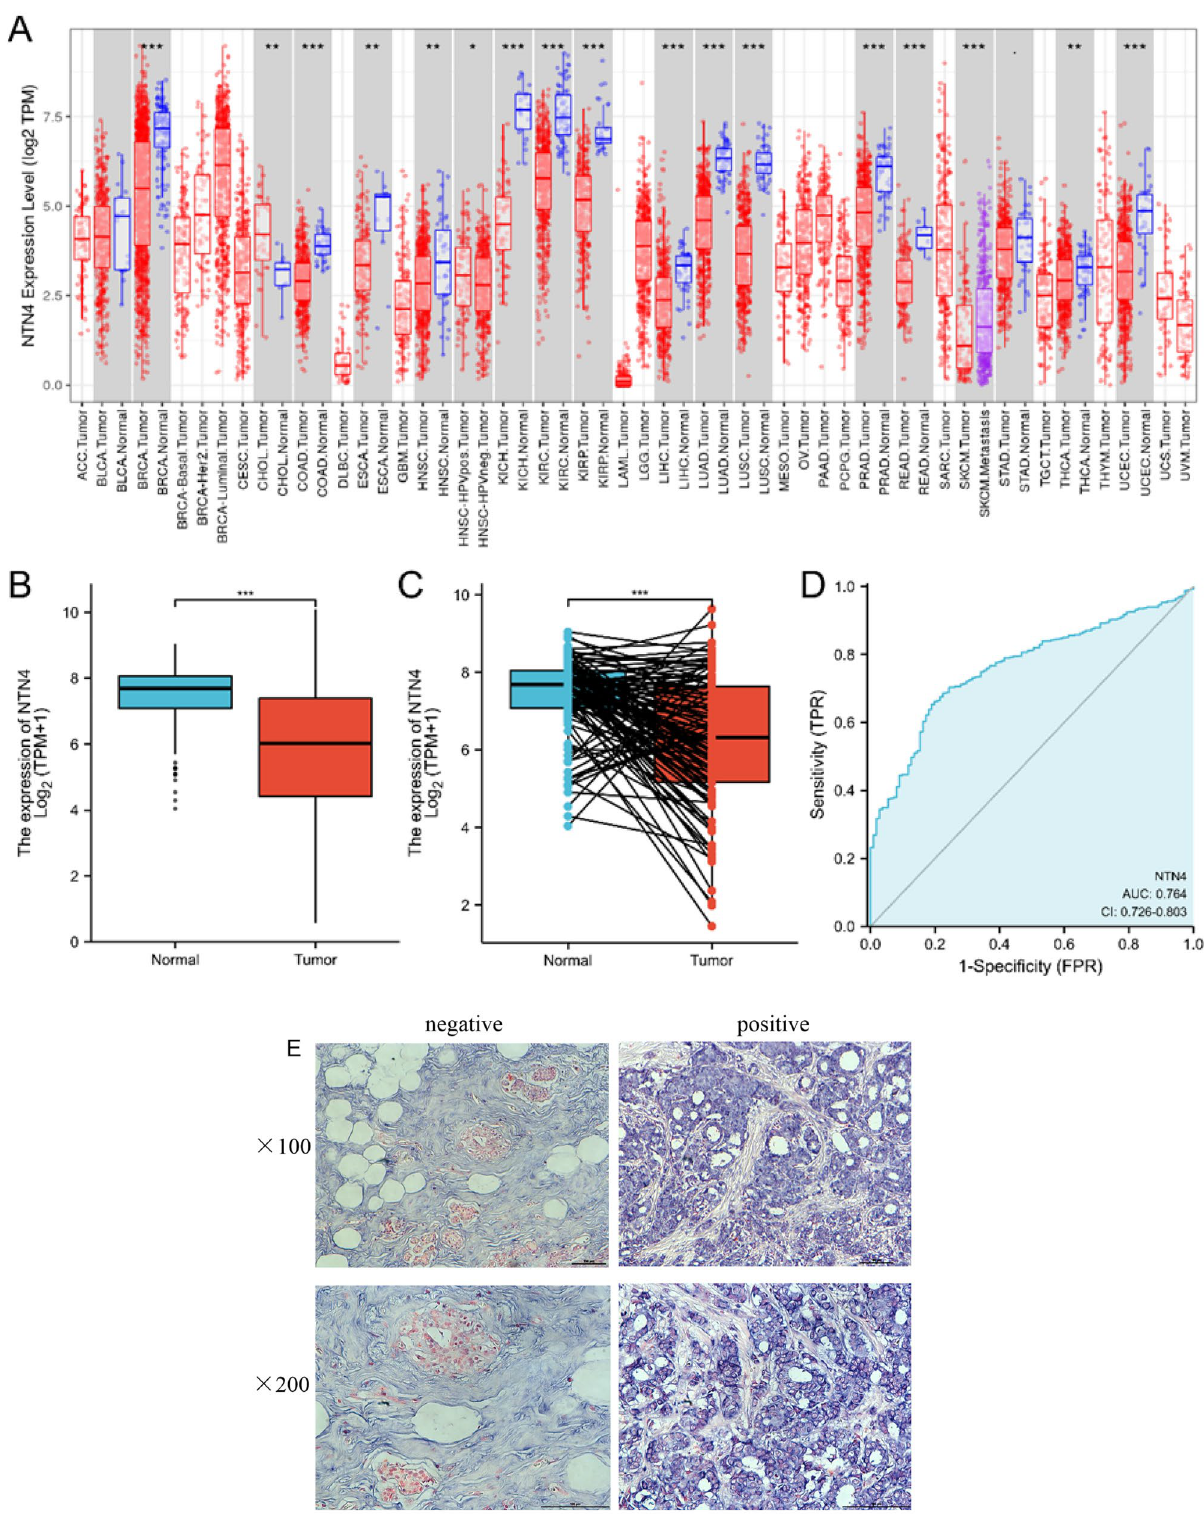
Figure 1. NTN4 expression and clinicopathological features of breast cancer. ( A ) NTN4 mRNA expression levels in different tumor types from TCGA database were determined by TIMER (*P < 0.05, **P < 0.01, ***P < 0.001). ( B ) Wilcoxon rank sum test was used to analyze differential expression of NTN4 between BC tumor and adjacent tissue. ( C ) Wilcoxon signed rank sum test was used to detect the differential expression of NTN4 between BC tumor and adjacent tissue. ( D ) ROC curve established efficiency of NTN4 mRNA expression level on distinguishing BC tumor from non-tumor tissue. X-axis represents false positive rate, and Y-axis represents true positive rate. (E): Representative negative (adjacent tissue) and positive (breast tumor tissue) expression of NTN4 protein as demonstrated by IHC. The magnification is 100 × (upper) or 200 × (lower),